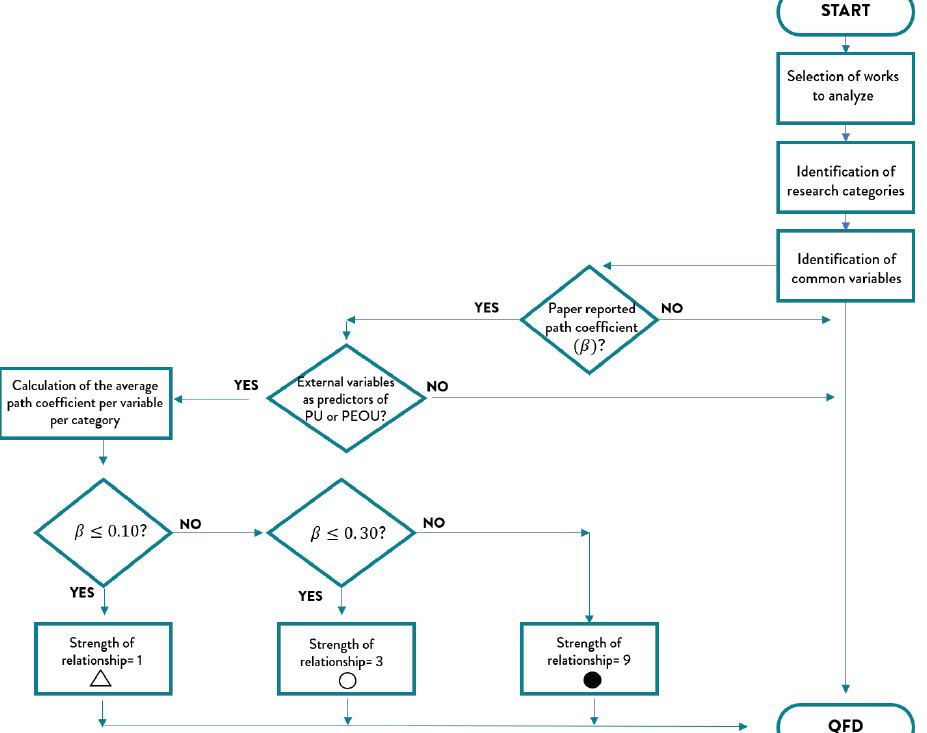
Figure 3. Proposed QFD matrix.